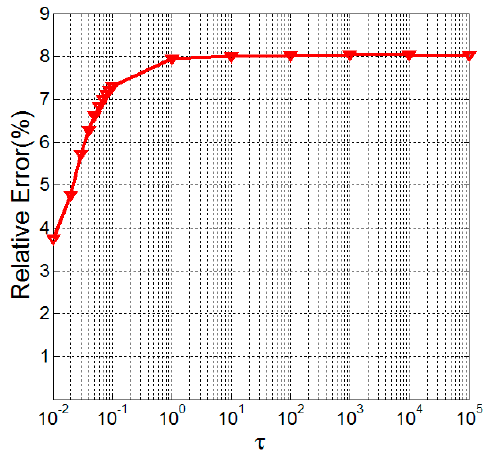
τ . Figure 2. Relative errors of Generalized Low-Rank Tensor Recovery (GLRTR) with varying τ